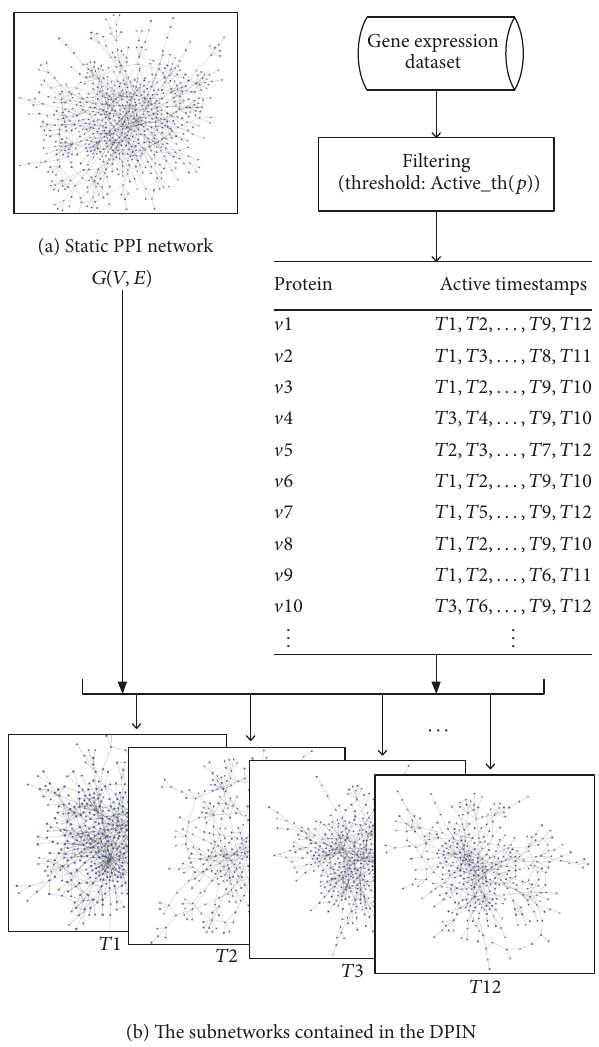
Figure 1: DPIN construction. (a) The static PPI network. (b) The subnetworks contained in the